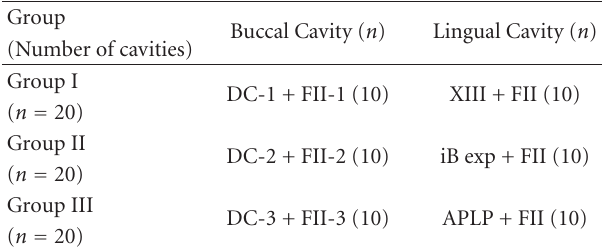
DC: Dentin Conditioner (GC Tokyo, Japan). FII: Fuji II LC (GC Tokyo,